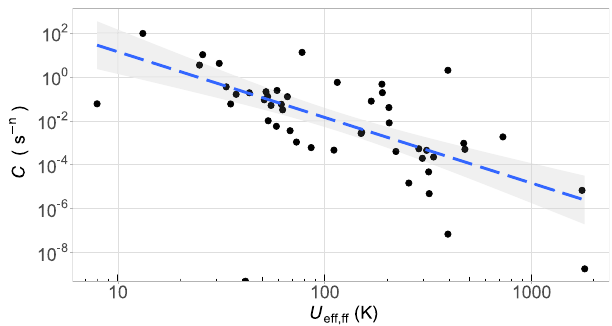
Fig. 5 | Relation between U eff,ff and Raman relaxation parameter C , in loga- rithmic form. Data points are accompanied by a least square fi t including con- fi dence